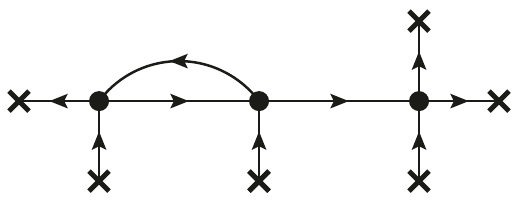
Figure 3 . The diagram corresponding to the invariant J (3 ; 3)